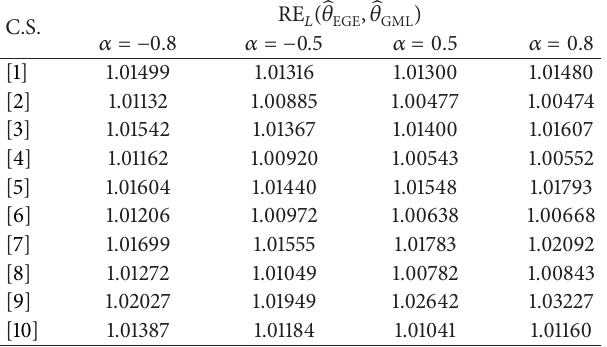
Table 6: GML and EB estimates of failure rate 𝜆(𝑡) for different values of 𝛼 .